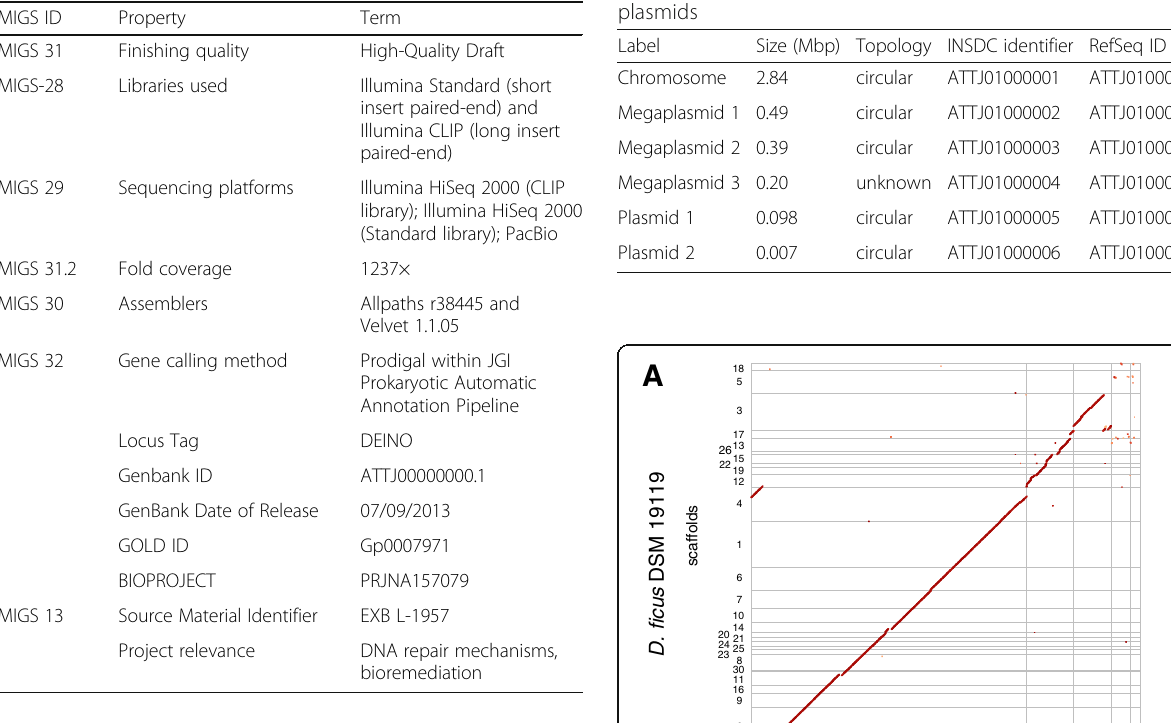
Table 3 Summary of genome: one chromosome and five